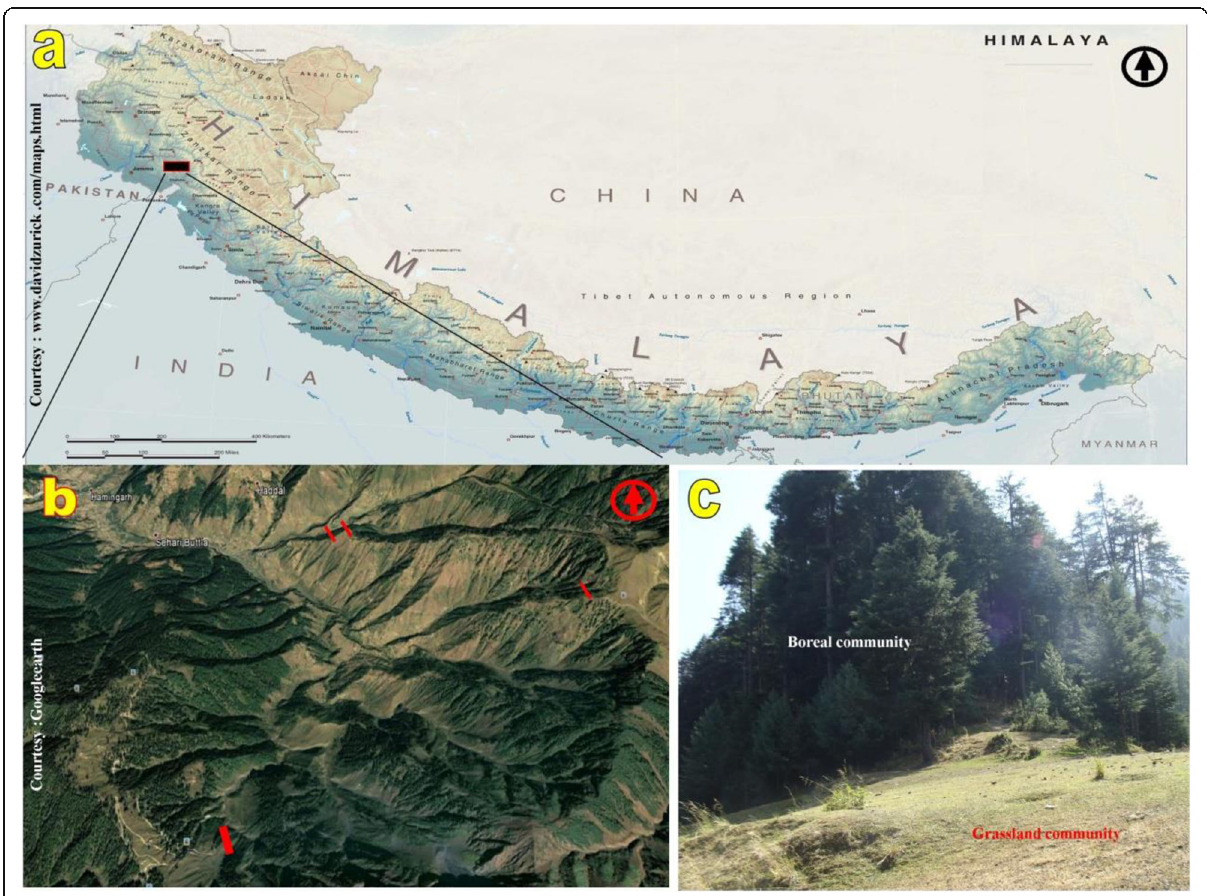
Fig. 1 Study area showing coniferous forest and grassland communities in the lesser stratum of NW Himalaya. a Himalaya mountain system. b Sampling sites (red strips) in the lesser stratum of in NW Himalaya. c A study site showing forest and grassland communities along the altitude gradient in the lesser stratum of NW Himalaya. Source: www.davidzurick.com/maps.html. Red color strips in b indicate the location of sampling sites